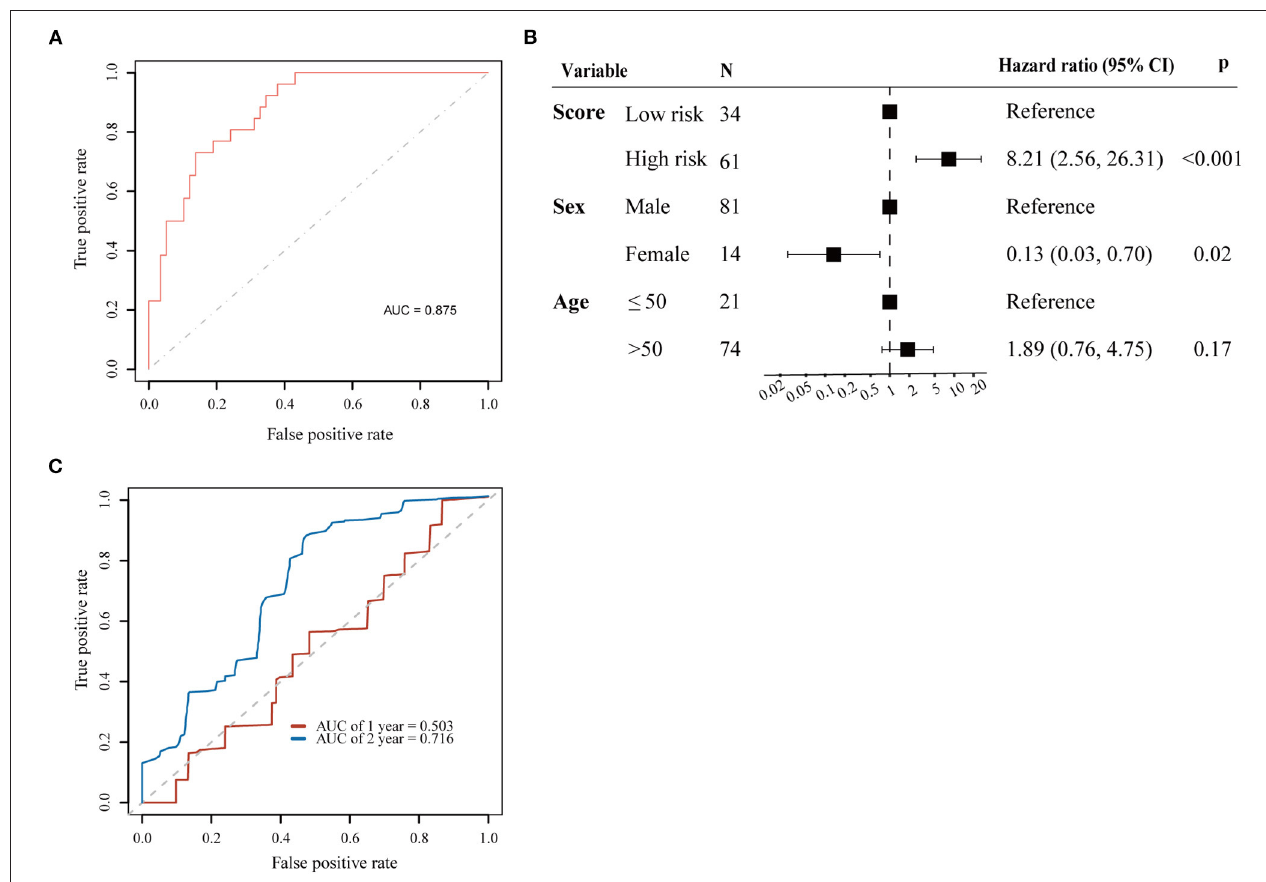
FIGURE 3 | Prognostic value for 13 genes selected by LASSO. (A) ROC curve for 13 key prognostic genes to survival status; (B) Cox proportional hazards regression analyses results for the 13-gene score; (C) ROC curves for predicting 1 and 2-year overall survival probability with the 13-gene score.